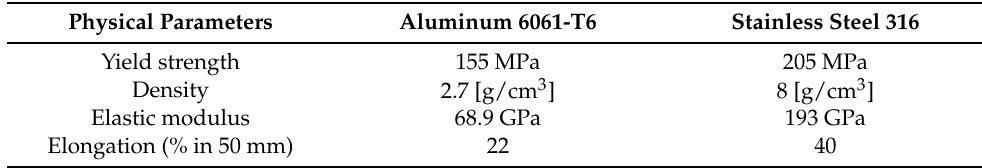
Table 1. Comparison of available materials for